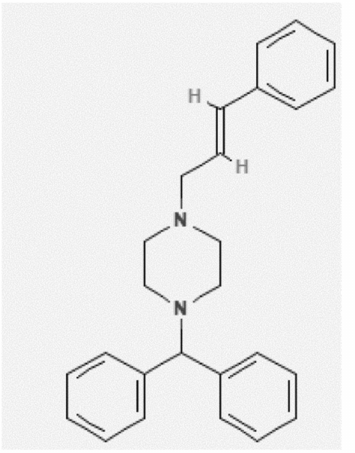
Figure 1. Molecular structure of cinnarizine